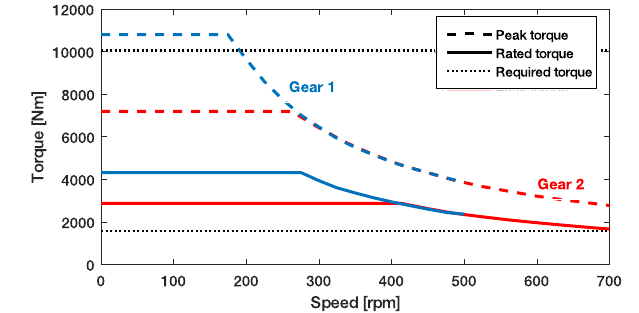
Figure 2 – Combined torque-speed curve of the traction motor and the transmission Рис. 2 − Общая характеристика электродвигателя и